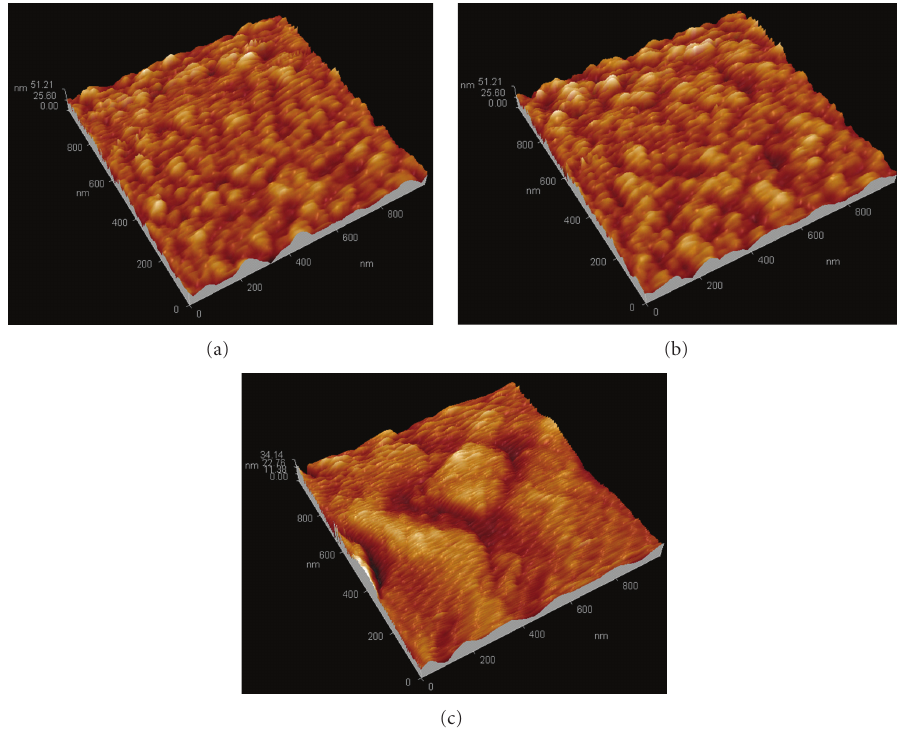
Figure 2: AFM images of the surface morphology of N-doped TiO 2 films under di ff erent temperature, (a) RT, (b) 200 ◦ C, and (c) 400 ◦ C.